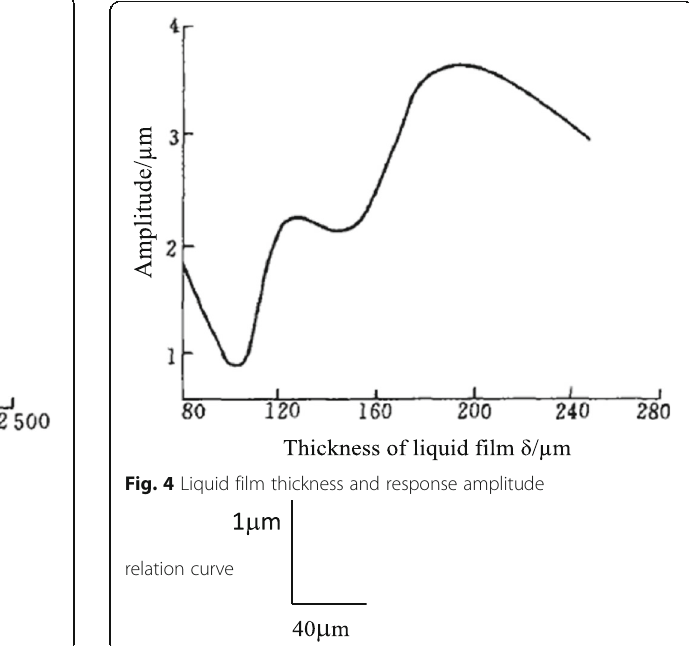
Fig. 4 Liquid film thickness and response amplitude relation